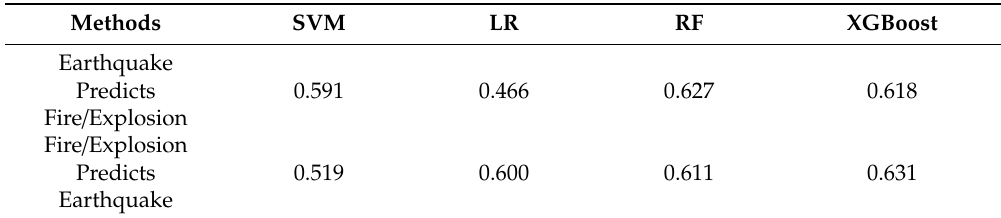
Table 6. F1 scores of cross-subclass prediction.